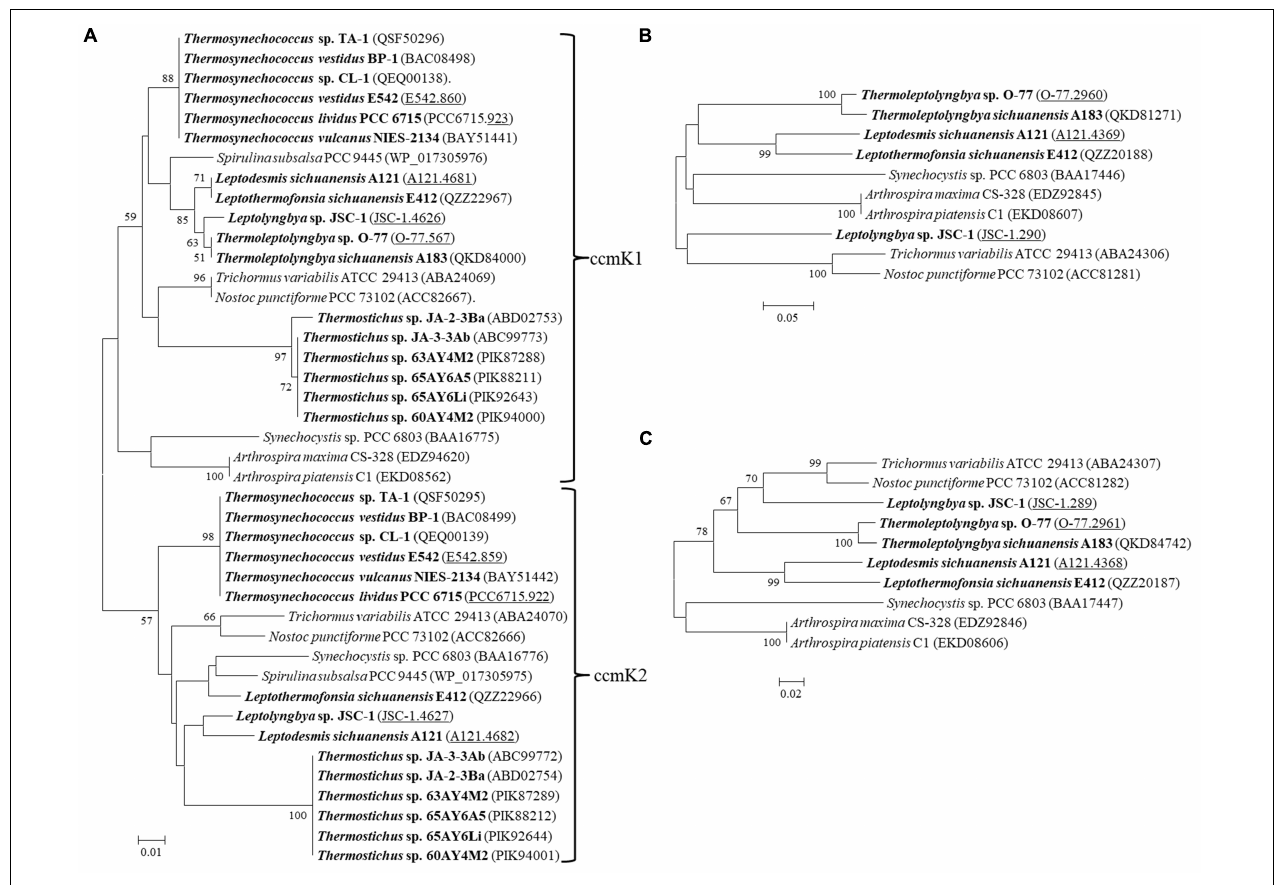
FIGURE 5 | Phylogenetic inference of protein sequences of ccmK1/2 (A) , ccmK3 (B) and ccmK4 (C) . The thermophilic cyanobacteria investigated in this study are indicated in bold. The accession numbers underscored refers to the gene IDs in Supplementary Table 1 . Only bootstrap values > 50% are indicated at